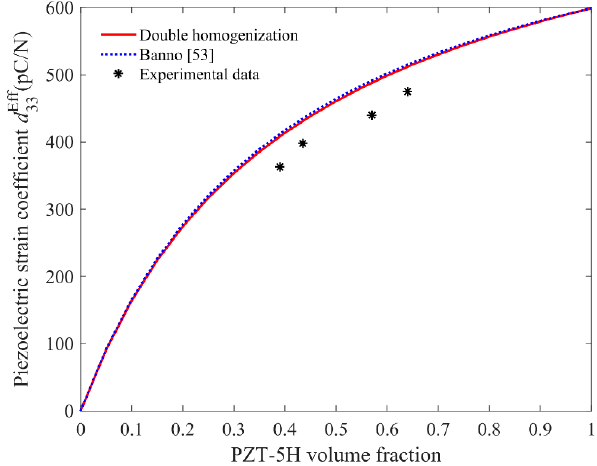
d and Eff d . d and Eff d . 31 32 . and d Eff 32 31 32 31